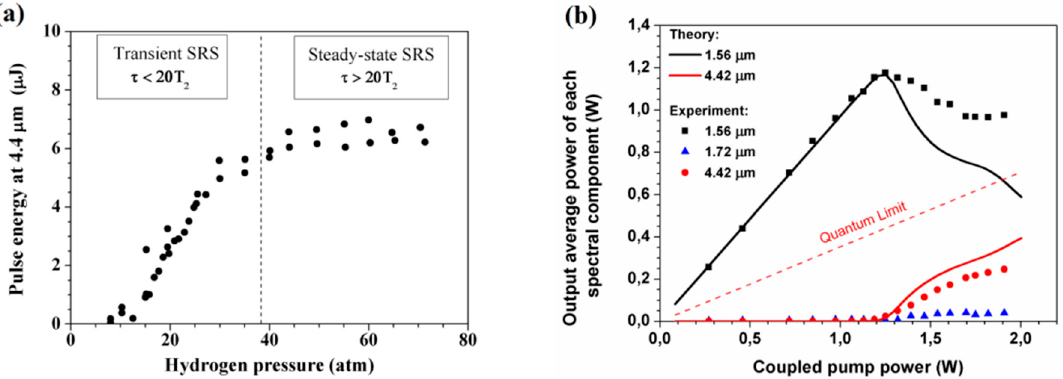
Figure 14. ( a ) Experimentally determined output pulse energy at 4.4 μ m as a function of 1 H 2 pressure in the hollow core [61]. The pump pulse duration was τ p = 3.5 ns. The vertical dashed line represents a pressure at which the dephasing time of molecular hydrogen vibrations satisfies the relation τ p = 20 · T 2 ; and, ( b ) Calculated (lines) and measured (data points) average output power of spectral components as a function of average launched pump power for the Raman GFL. Different colors correspond to different spectral components: 1.56 μ m (black), 1.72 μ m (blue), and 4.42 μ m (red). Dashed red line represents a quantum limit for 4.42 μ m generation. The measurements and calculations were made at the optimal fiber length (3.2 m) and hydrogen pressure (50 atm) [61].